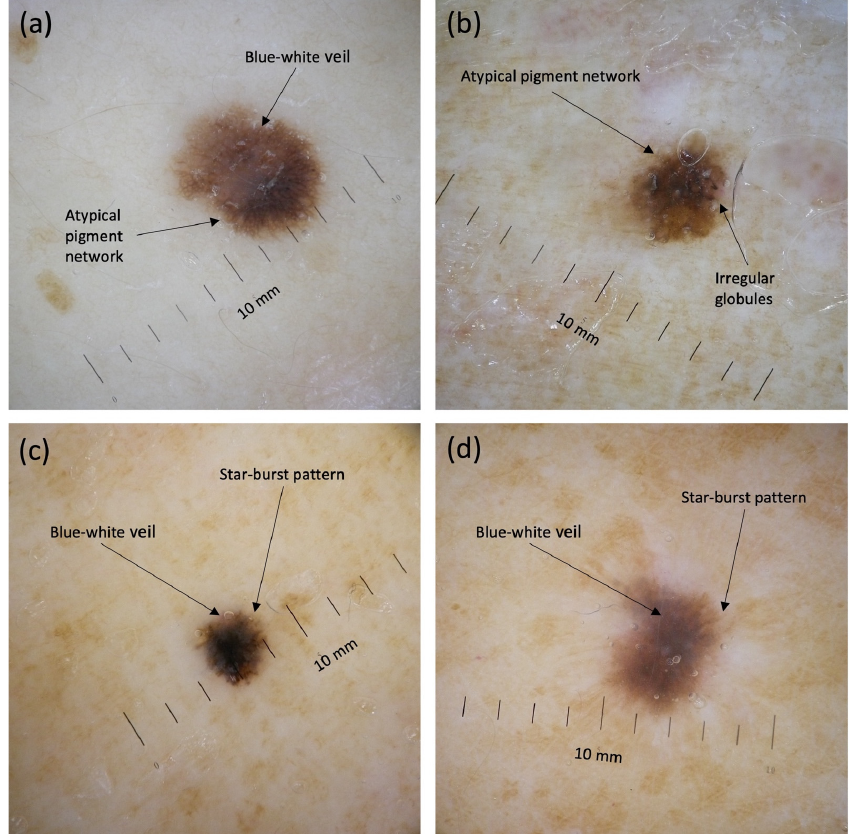
Figure 2. Dermoscopy of four representative small-diameter melanomas, including invasive pT1a ( a , c , d ) and in situ melanomas ( b ). Dermoscopic features of depicted lesions include an atypical pigment network ( a , b ), subtle irregular globules ( b ), a blue–white veil ( a , c , d ), and a starburst pattern ( c , d ).